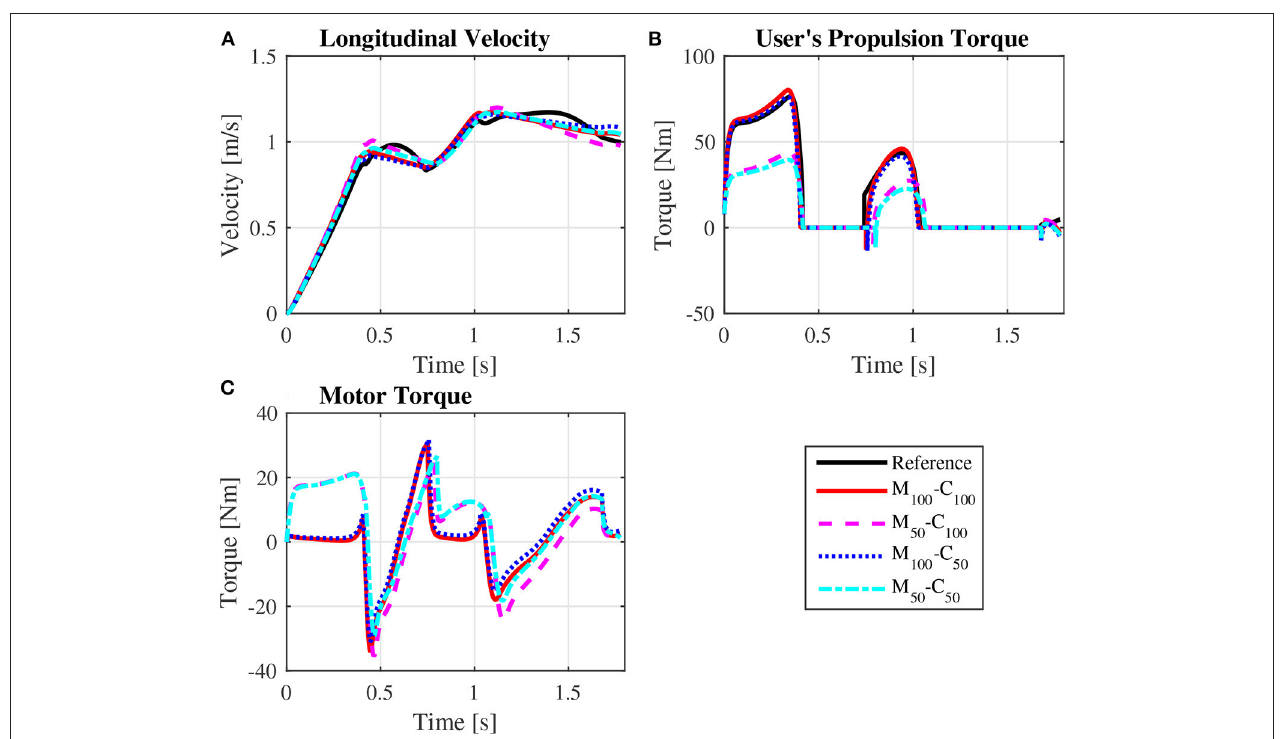
FIGURE 5 | Predicted wheelchair speed profile (A) , bilateral propulsion torque applied by the user (B) , and bilateral torque applied by the motors on the rear wheels of the wheelchair (C) along the sequence of phases propulsion-recovery-propulsion-recovery-propulsion in the startup locomotion on a level surface at an average speed of 0.9 m/s for the reference unassisted condition (Reference), and for the assisted locomotion with 100% of reference model parameters Mi and Ci (